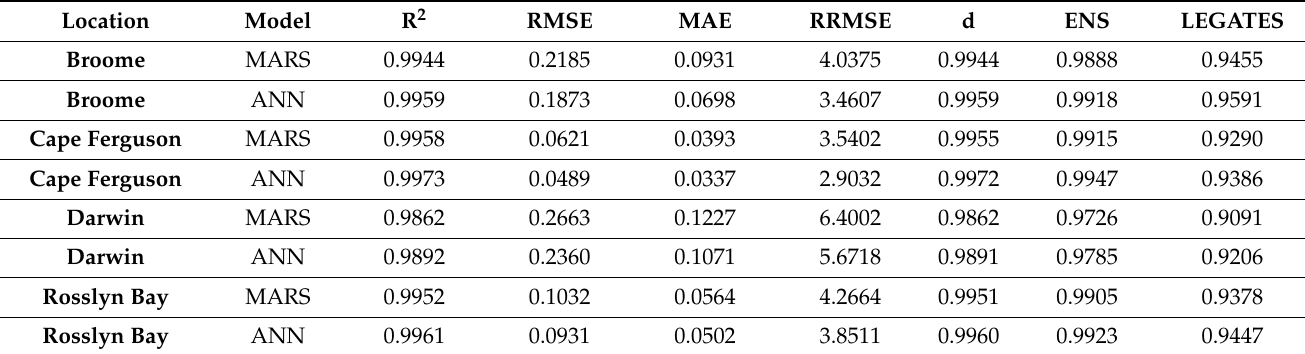
Table 5. Training metrics for both models at all locations.